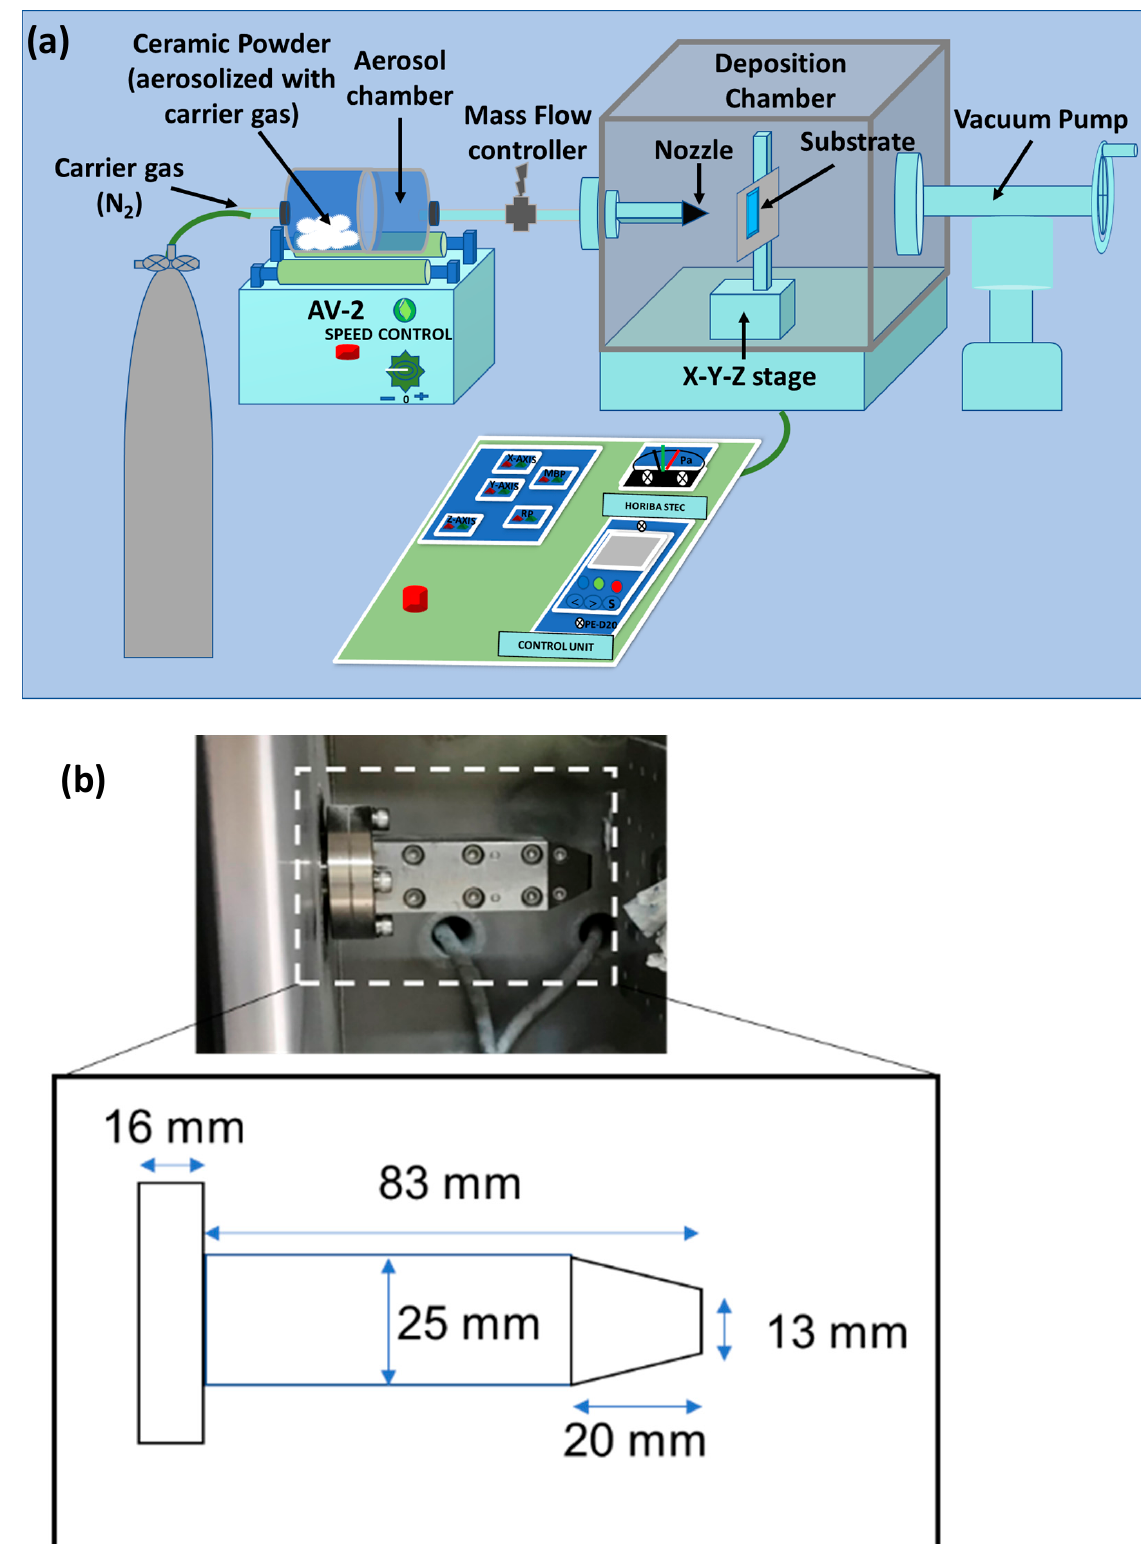
Figure 1. ( a ) Schematic diagram of the AD process, and ( b ) the geometry of the nozzle.